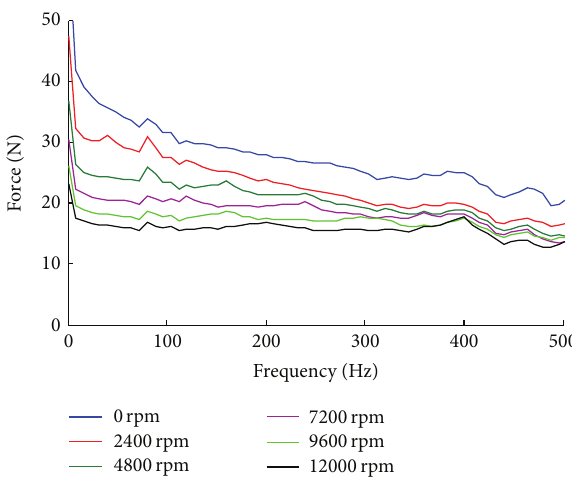
Figure 9: Relationship between electromagnetic force and exciting frequency at different speeds.